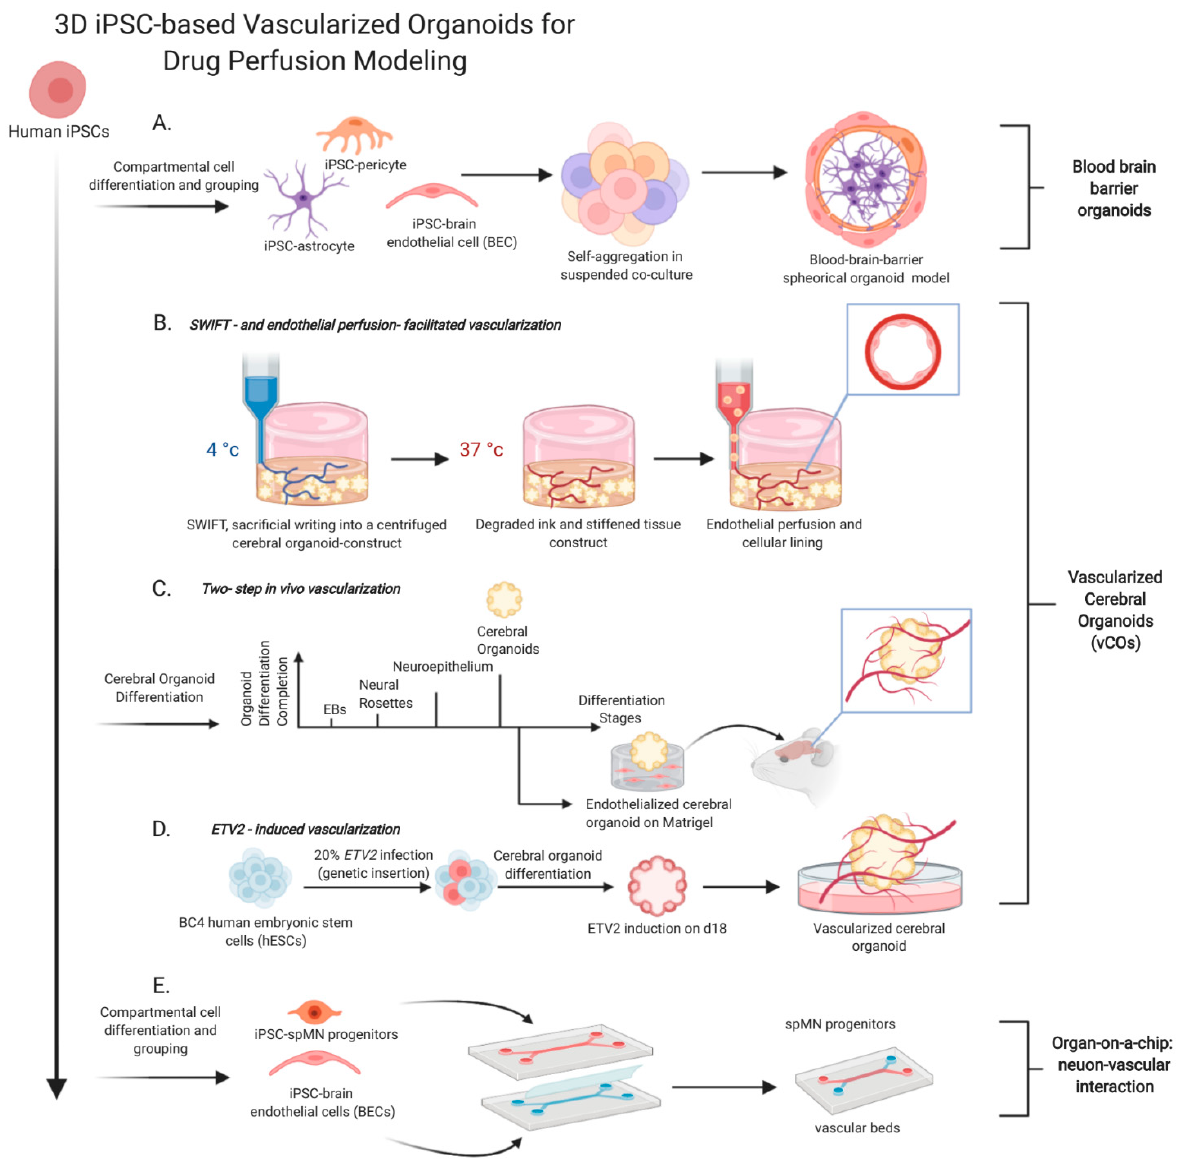
Figure 1. 3D induced pluripotent stem cell (iPSC)-based vascularized organoids for drug perfusion modeling. ( A ) iPSC- derived blood-brain-barrier model. Astrocytes, pericytes and endothelial cells are generated from human iPSCs and mixed in suspension for self-aggregation. The resulted spheroid comprises an inner layer of astrocytes, intermediate layer of pericytes, and an outer layer of endothelial cells. ( B ) Scaffold-dependent vascularization of organoids through sacrificial writing into functional tissues (SWIFT). Cerebral organoids are mixed and compacted into a solid-like construct in an appropriate extracellular matrix medium. The sacrificial gelatin ink is 3D typed into the tissue construct. The tissue construct solidifies with increased temperature, while the sacrificial ink melts away, leaving tubular structures embedded within. Perfusion of endothelial cells endothelializes the interior of the channels and form vascular beds. ( C ) External revascularization of human iPSC-cerebral organoids within mouse brain cavity. Non-vascularized organoids are seeded onto endothelial containing matrigel droplets DIV 34 and transplanted onto raw edges of the resection cavity in the mouse brain. ( D ) ETV2 -facilitated endogenous vascularization of cerebral organoids in vitro . A mixture of BC4 hECs and ETV2-infected BC4 hECs is prepared with a 20% cell infection rate. On day 18 of organoid differentiation, viral induction is initiated. Endothelial tubes are formed along the organoid differentiation and continuously evolve with increased structural complexity. ( E ) A dual-channeled microifluidic organ/organ-on-a chip (OoC) to model neural-vascular interactions. Human iPSC-derived spinal neural progenitors (hiPSC-spNPs) are seeded on the top channel and iPSC-derived brain endothelial cells (BECs) on the bottom. Vasculature develops as the neural progenitors differentiate into spinal neurons with mediated signaling between two different cell types.